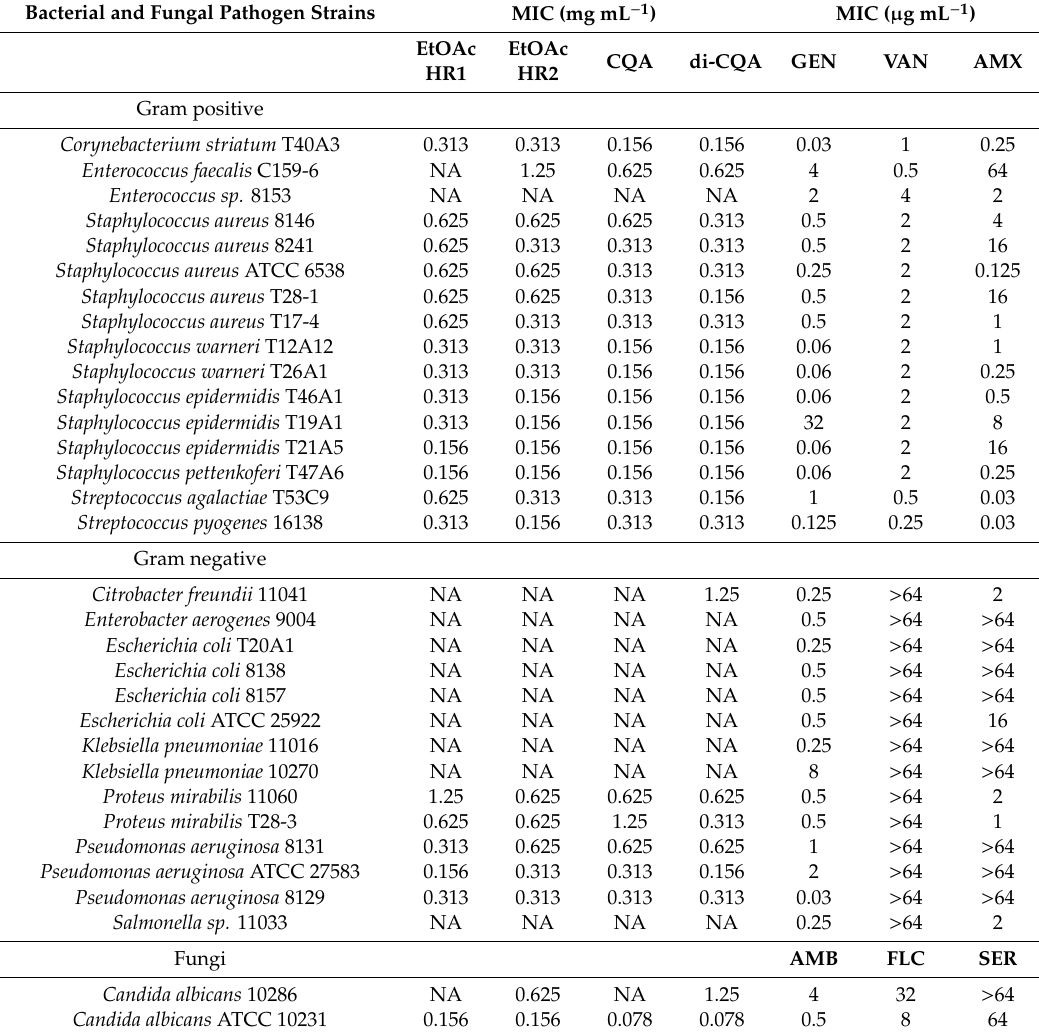
Table 2. MICs (mg.mL − 1 ) of ethyl acetate sub-extracts of chicory hairy roots (EtOAc HR1, ethyl acetate sub-extract of not elicitated hairy roots; EtOAc HR2, ethyl acetate sub-extract of elicitated hairy roots) and two pure compounds (CQA, 3-ca ff eoylquinic acid; di-CQA; 3,5-dica ff eoylquinic acid) against some human pathogenic bacteria and fungi. MICs (in µ g · mL − 1 ) of some antibiotics (GEN, gentamicin; VAN, vancomycin; AMX, amoxicillin) and antifungal agents (AMB, amphotericin B; FLC, fluconazole; SER, sertaconazole) against the same pathogens